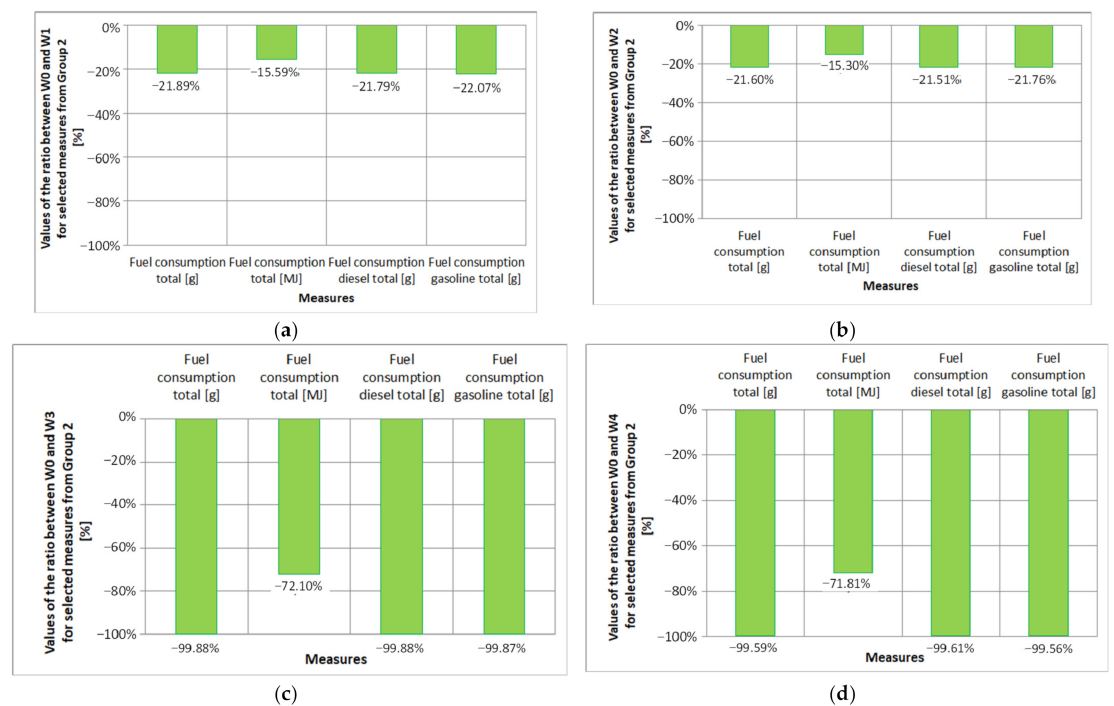
Figure 25. Values of the ratio between W0 and individual scenarios W1–W4 for selected measures from Group 2—analysis for the whole city: ( a ) the ratio between scenario W0 and W1; ( b ) the ratio between scenario W0 and W2; ( c ) the ratio between scenario W0 and W3; ( d ) the ratio between scenario W0 and